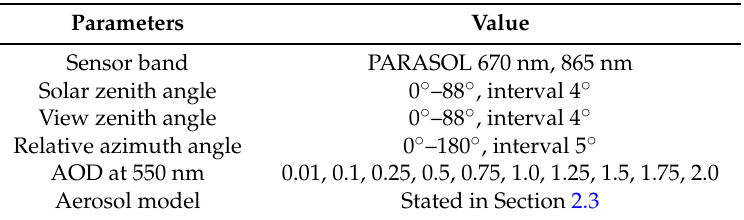
Table 4. The input parameters of the lookup table for